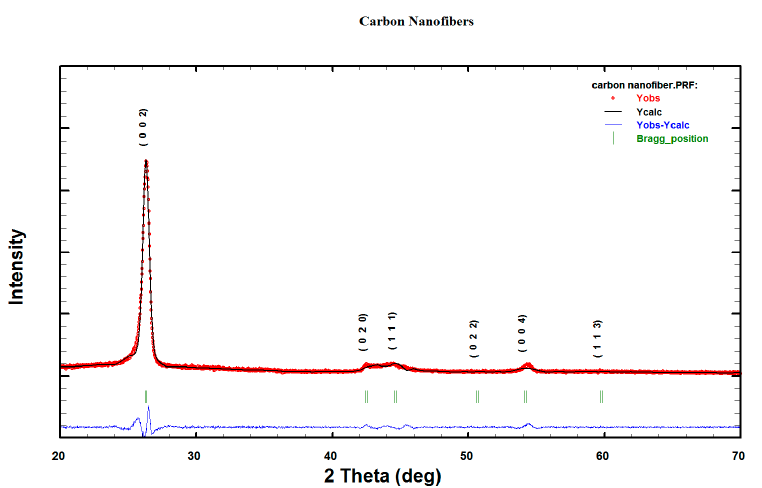
Figure 6. ECNFs XRD Rietveld difference plots. Measured and calculated patterns shown by red circles and solid black line, respectively. Difference between calculated and measured pattern and peak positions ((002), (020), and (004)) shown by blue residual plot and green bars, respectively.